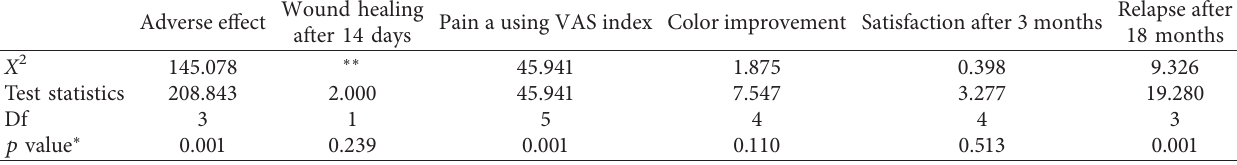
Table 2: Statistical analysis using the one-sample chi-square test ( X 2 ) and one-sample binomial test to determine the significant difference between our null hypothesis to the actual observed data using Er,Cr:YSGG laser.